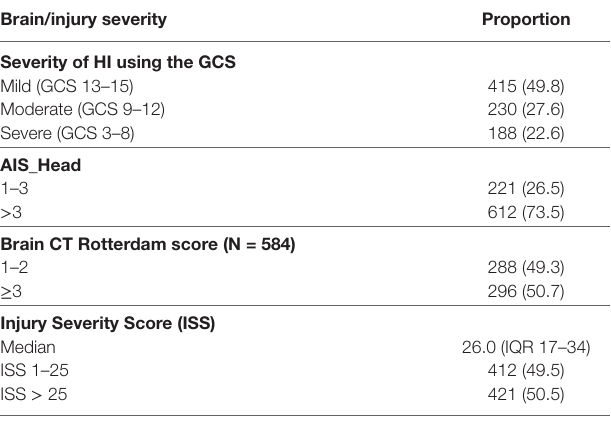
Table 4 | Road-traffic injury-Related head injury (HI) from Nigeria: brain and systemic trauma severity categorization. brain/injury severity